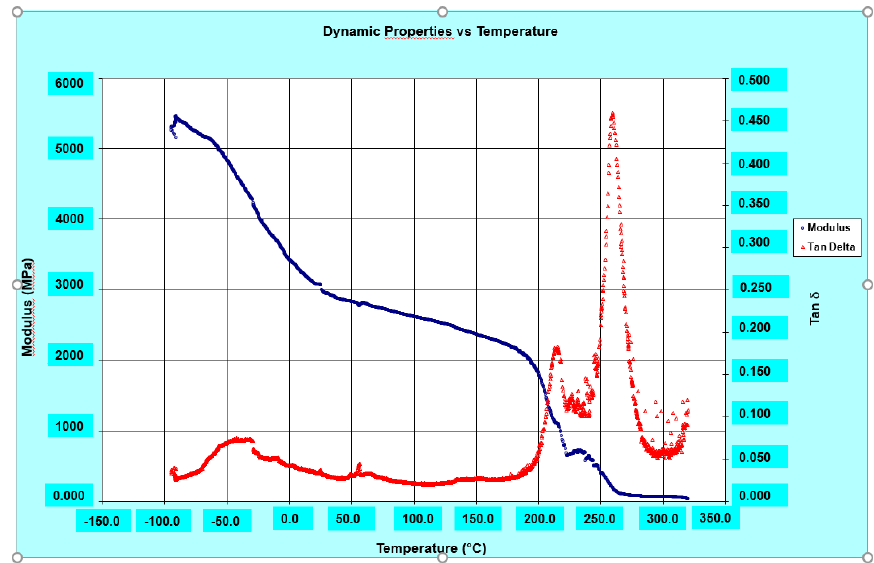
Figure 11. Loss factor (tan δ ) and Storage modulus of the R0.5%G-py nanocomposite. Nanomaterials 2020 , 10 , x FOR PEER REVIEW